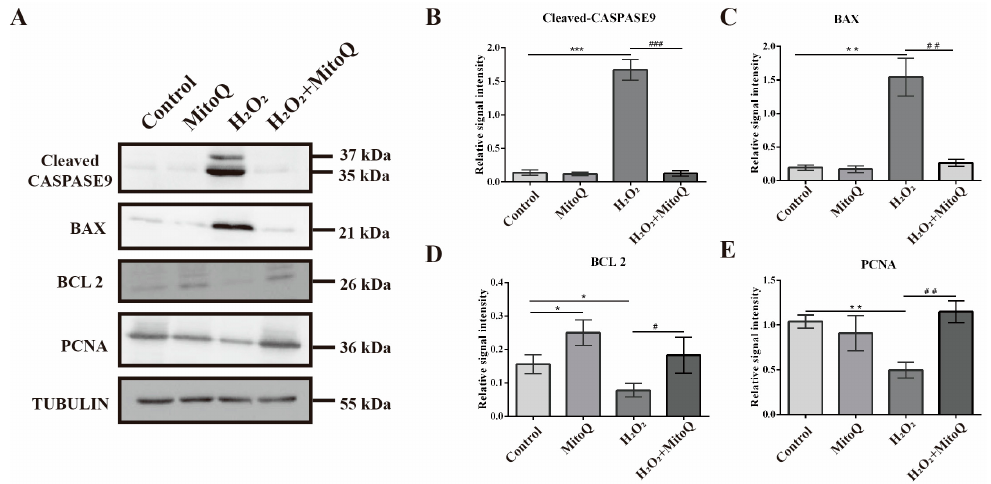
Figure 6. MitoQ can prevent cell damage induced by H 2 O 2 -induced apoptosis. ( A ) CASPASE 9, BAX, BCL 2, and PCNA protein expression detected by Western blot (n = 3). TUBULIN was used as a loading control. ( B – E ) Quantification of Western blot results. Error bars indicate SD. * p < 0.05, ** p < 0.01, *** p < 0.001, vs. control group. # p < 0.05, ## p < 0.01, ### p < 0.001, vs. H 2 O 2 group.